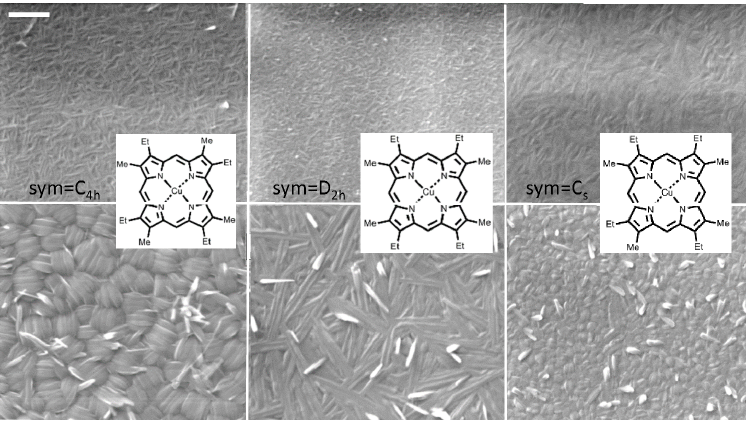
Figure 2. SEM images of the Cu-EtioPs films deposited on cold ( top panels , from [1]) and hot ( bottom panels ) silicon substrates in similar conditions, insets—molecular structures and symmetry of isomers. The white mark in the left top corner corresponds to 1 µ